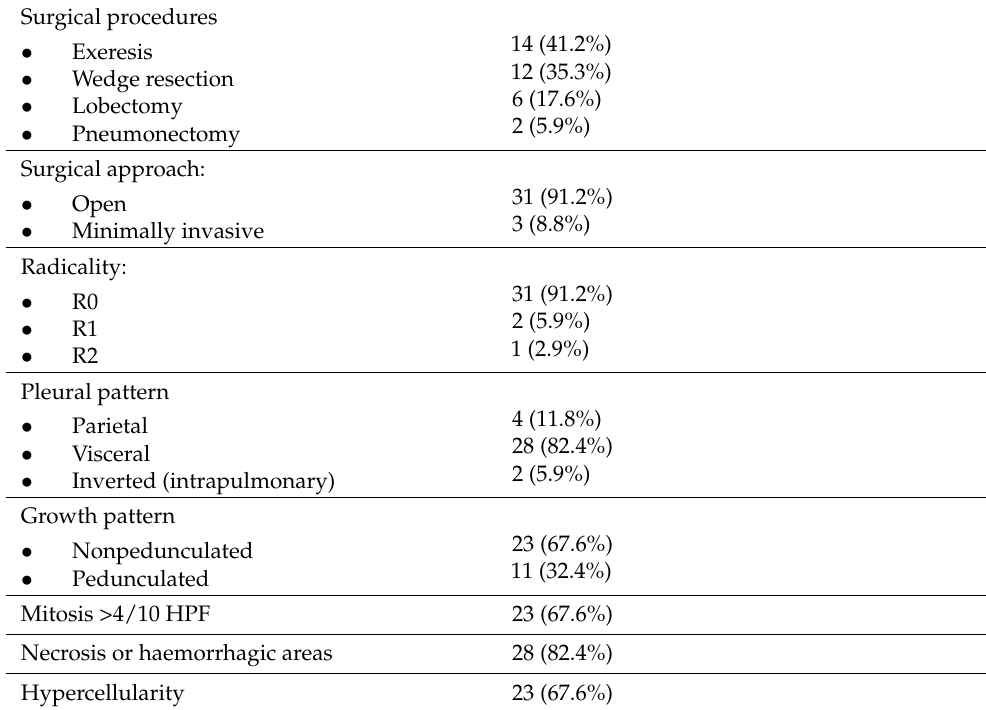
Table 3. Surgical procedures, tumour characteristics and risk stratification. Surgical procedures